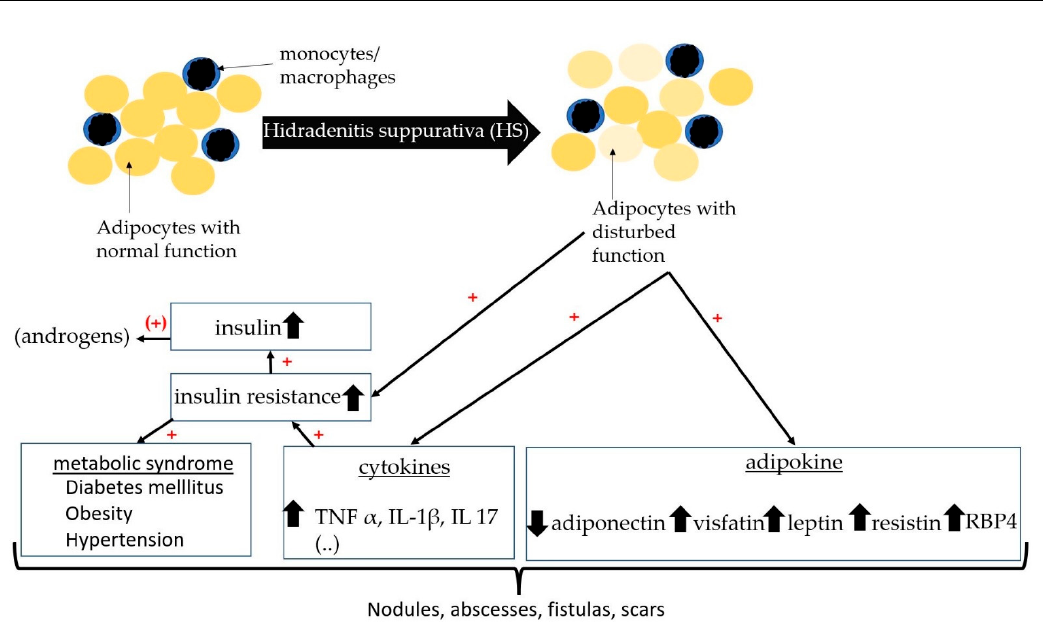
Figure 2. Schematic diagram with relationship between insulin resistance, adipokines, and HS.